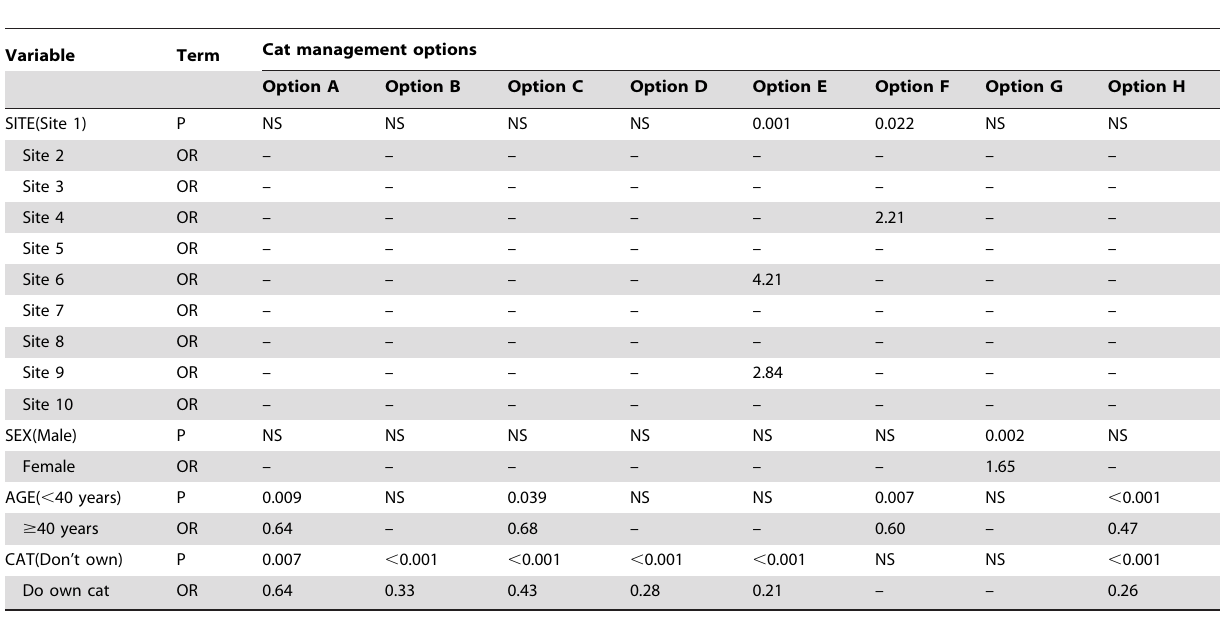
Table 2. Summary of results of binary logistic regression models examining the acceptability of eight different cat management options (see Figure 7) (N =665